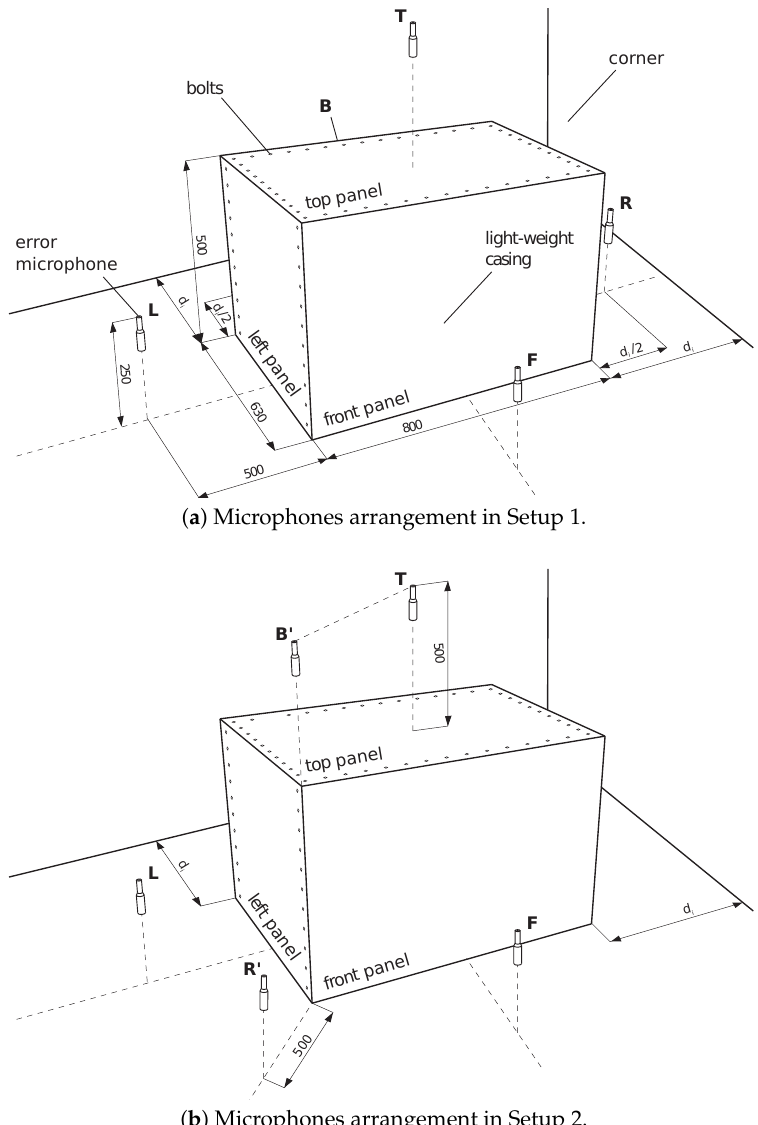
Figure 2. The schematic representation of the laboratory setup (all dimensions are given in